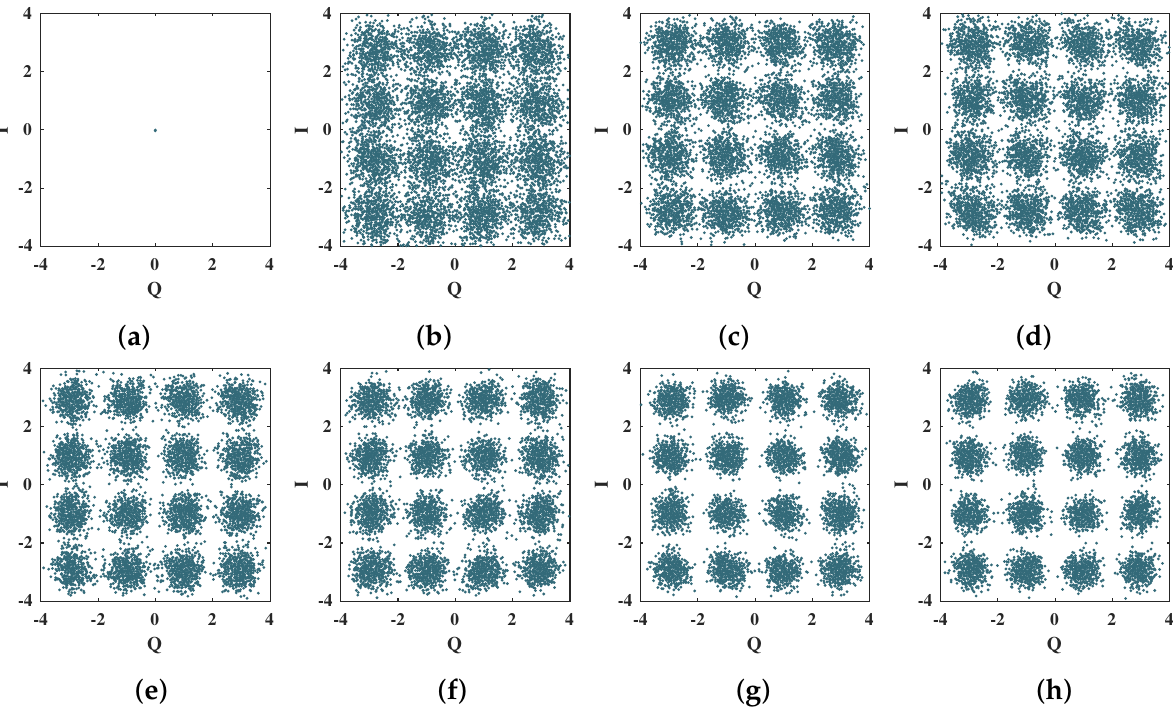
and ( h ) 35 epochs. (d) 15 epochs, (e) 20 epochs, (f) 25 epochs, (g) 30 epochs, and (h) 35 epochs.